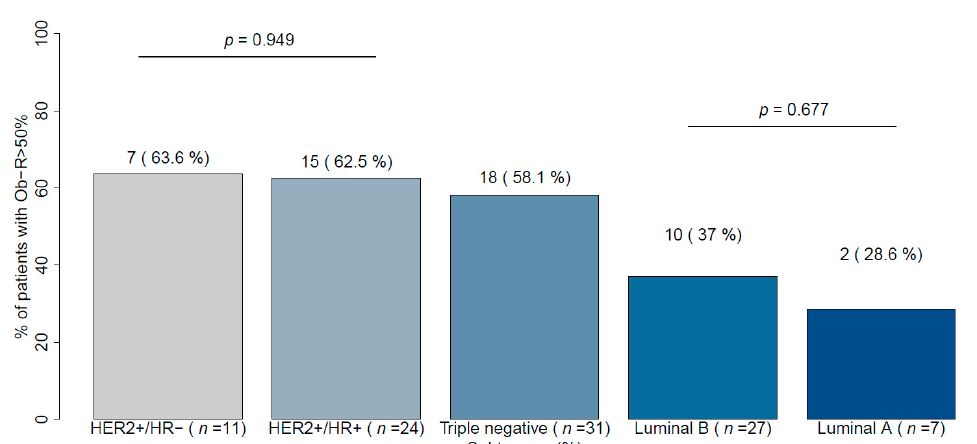
Figure 4. Ob-R cell overexpression (>50%) in accordance with cancer classification in ( A ) three molecular subtypes and ( B ) five molecular subtypes. HER2: Human epidermal growth factor receptor 2; HR: Hormonal receptor; Ob-R: Leptin receptor.